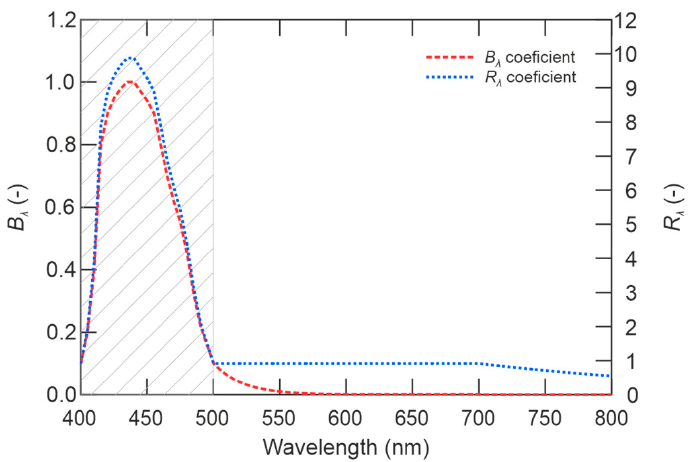
Figure 17. Spectral weighting coefficients B λ and R λ (adapted from [48]).